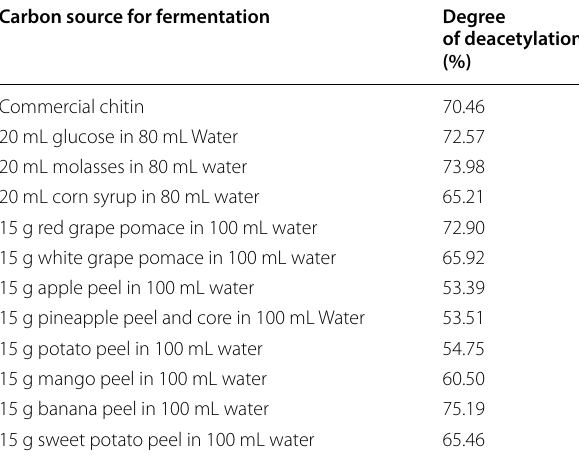
Table 2 Degree of deacetylation of chitin extracted after fermentation on various carbon